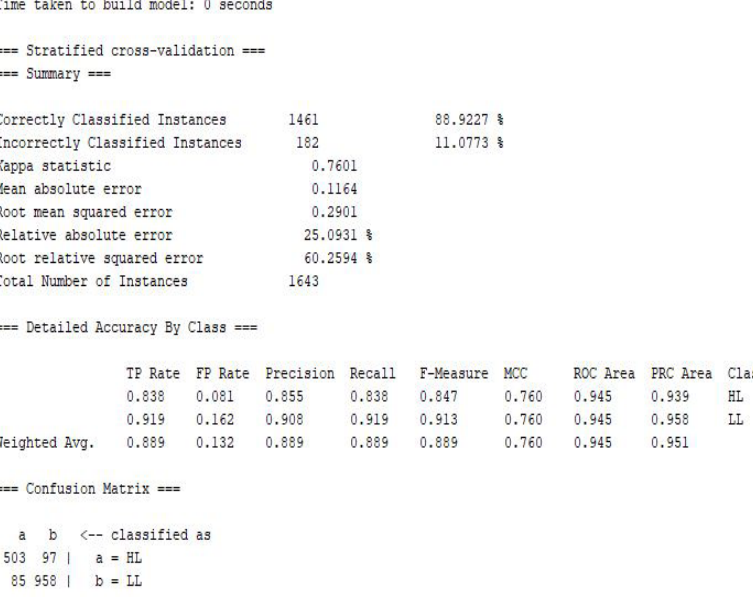
Figure 5: Naïve Bayes (NB) model for training dataset